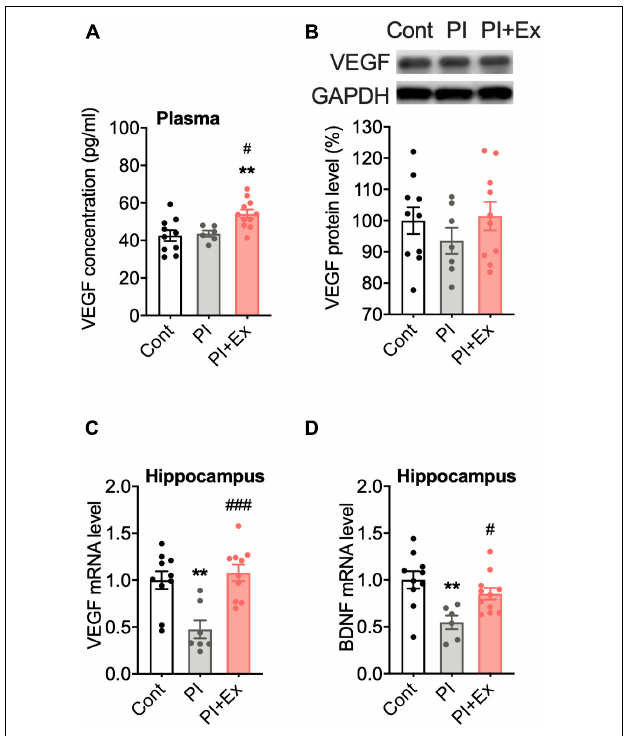
FIGURE 9 | Regular low-intensity exercise increased plasma VEGF concentration and hippocampal BDNF and VEGF mRNA expression. (A) Plasma VEGF concentration. (B) Representative gel image of western blot analysis for VEGF protein expression in the gastrocnemius muscle. (C) Relative mRNA level for VEGF in the hippocampus. (D) Relative mRNA level for BDNF in the hippocampus. All data are presented as the mean ± SEM (Cont mice, n = 10; PI mice, n = 7; PI + Ex mice, n = 10). Data were analyzed using one-way ANOVA with Tukey’s post-hoc test. **p < 0.01, in comparison with the Control mice and # p < 0.05, ### p < 0.001 in comparison with the PI